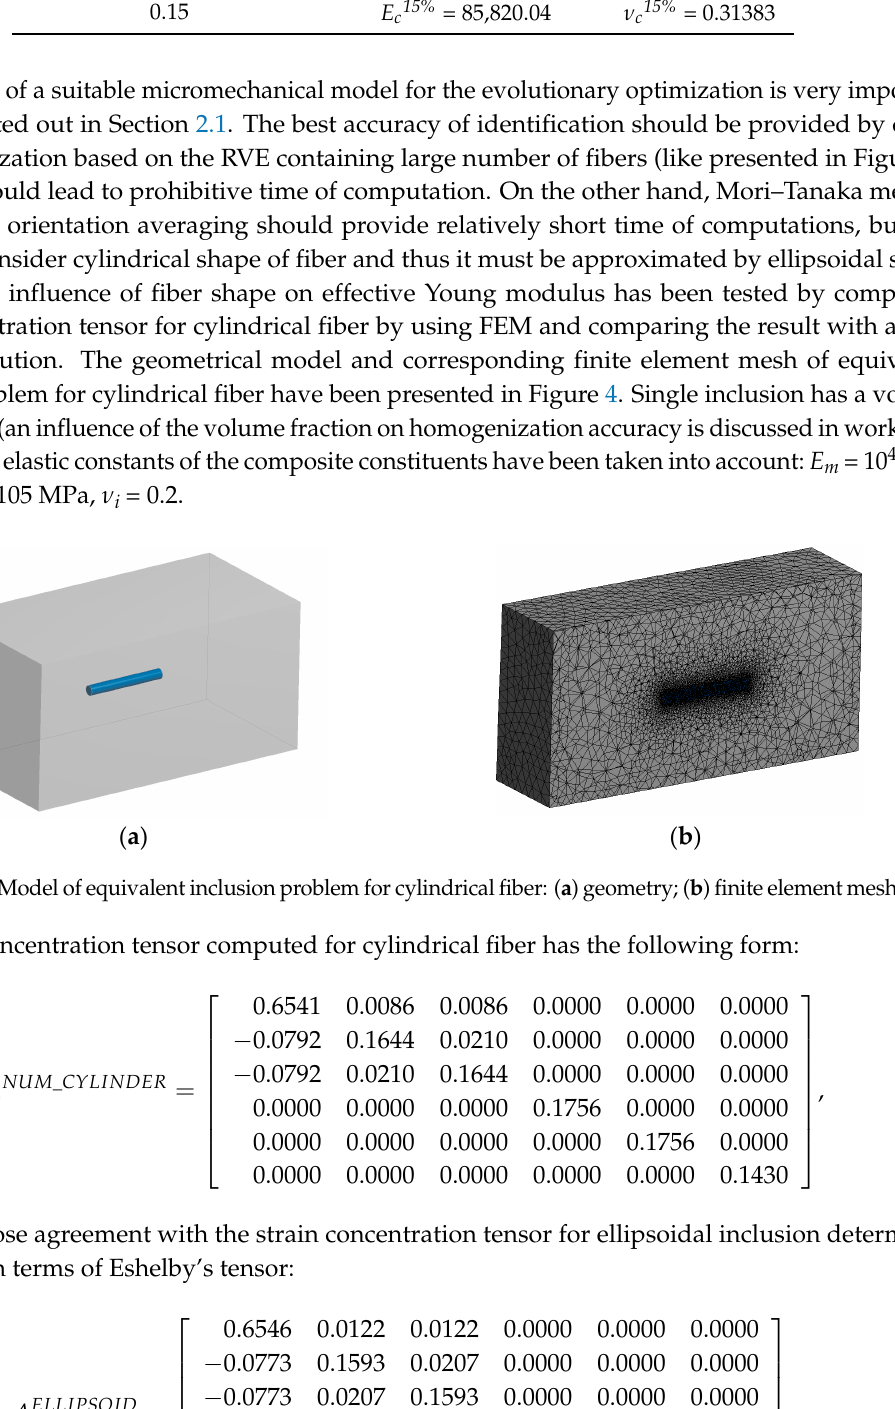
Table 1. Elastic properties of matrix and fiber.